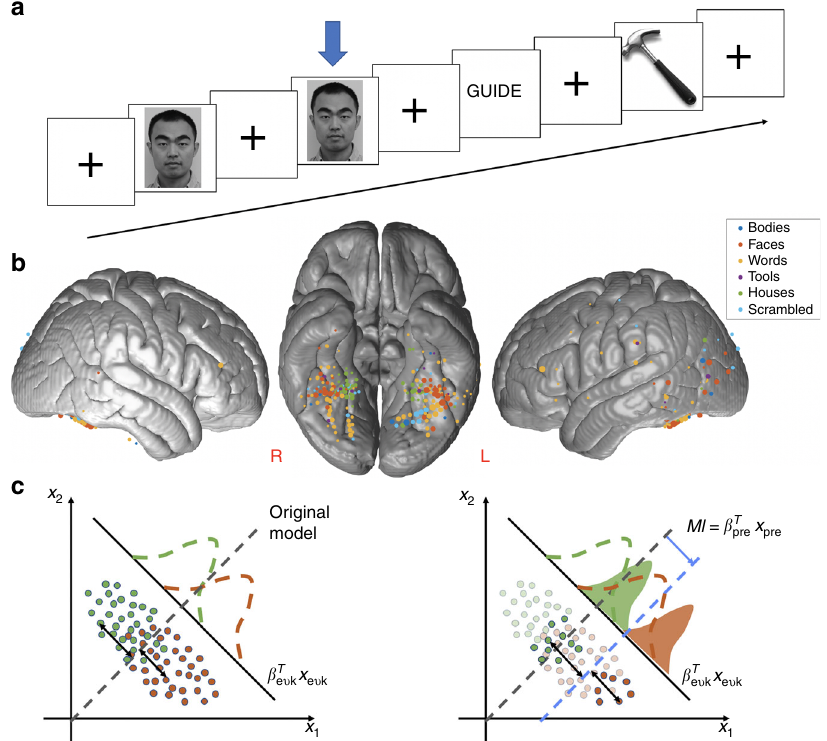
Fig. 1 Behavioral task, the category-selective electrodes, and the algorithm framework. a Experimental paradigm in which the subject is shown a series of images and performs a 1-back exact image repeat detection task. 180 images from 6 categories (faces, bodies, words, tools, houses, scrambled non- objects) were used. Each image was presented for 900 ms, with 900 ms inter-stimulus interval. b The lateral and ventral views of the locations of the 246 category-selective electrodes mapped onto a common brain surface. Color coded according to the category-selectivity of each electrode. Size of the marker indicates the relative strength of category-selectivity. The category-selectivity was determined based on (1) signi fi cant sensitivity index ( d ′ ) for certain category using a 6-way classi fi er and (2) larger event-related potential (mean stP) or broadband high-frequency activity (mean stBHA) over other categories. ( c ) Illustration of the statistical model that uses pre-stimulus to modulate trial-by-trial classi fi cation boundary. x 1 , x 2 are post-stimulus features, solid black line indicates the critical discriminant dimension extracted from post-stimulus distributions that maximally separate the two categories, dashed lines indicate the classi fi cation boundary. In this algorithm, a classi fi er is fi rst trained on just the post-stimulus activity (left panel, equivalent to no pre- stimulus modulation: green and orange dots are samples from two categories; dashed curves are the density plots of the two categories; dashed gray line is the post-stimulus classi fi cation boundary). The model then learns the relationship between the optimal classi fi cation boundary and the pre-stimulus activity pattern. The right panel shows an example case where the opaque dots and the solid density plots are the conditional distribution given a particular pre-stimulus activity. In this case, the optimal decision boundary (dashed blue line) is shifted to the right from the original boundary (dashed gray line). The model is sensitive to other types of shifts that may be associated with different pre-stimulus activity patters as well, such as a relationship between the pre- stimulus activity and the variance of the neural response. The size of this shift is the modulation index (MI; blue arrow).